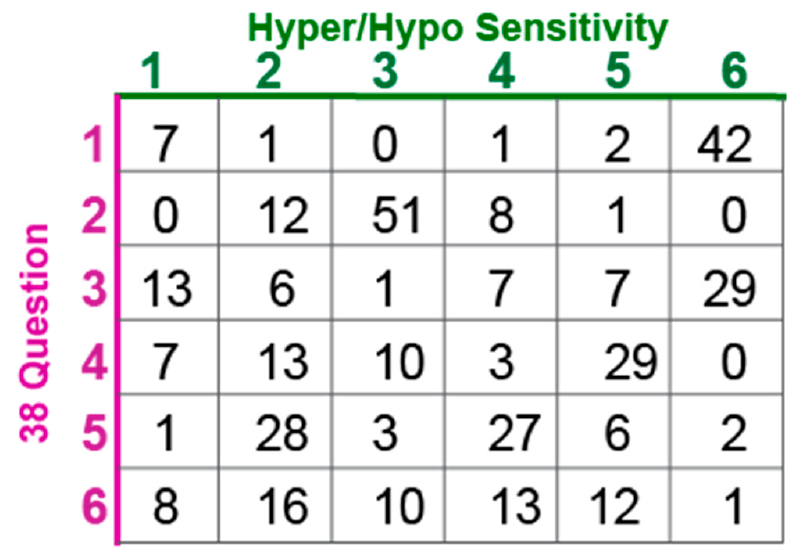
Figure 6. Participant overlap between clustering methods for K = 6. Participants assigned to group 3 in the 38Question analysis overlapped best with group 6 (29/63) and group 1 (13/63) from the Hyper/hypo sensitivity analysis. This group was characterized by differences in tactile sensitivity, auditory filtering, and underrespon- sive/seeking on the 38Question analysis which was consistent with differences in both hyper- and hypo- sensitivity for tactile and auditory processing. Therefore, we call this sub- group “Tactile and Auditory.” Participants assigned to group 4 in the 38Question analysis overlapped best with Hyper/hypo sensitivity analysis group 5 (29/62). Unlike the prior group, these participants were uniquely hypo-sensitive in the areas of touch and hearing as evidenced by the Hyper/hypo sensitivity analysis and underresponsive/seeking on the 38Question analysis. Therefore, we call this subgroup “Tactile and Auditory Hyposensitive.” Participants assigned to group 5 in the 38Question analysis overlapped best with group 2 (28/67) and group 4 (27/67) on the Hyper/hypo analysis. This combination was particularly interesting to us because group 5 in the 38Question analysis was defined by differences in taste and auditory sensitivity whereas groups 2 and 4 in the Hyper/hypo analysis were defined by auditory hypo-sensitivity and taste hyper-sensitivity